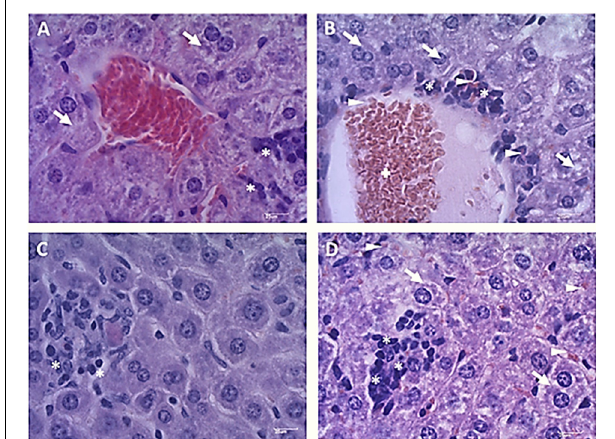
nuclei positioned at the cell center were observed. Differences in the number of glomerular corpuscles, changes in the Bowman’s space and tubule diameters were observed ( Supplementary Table S4 ). No significant differences were observed between the renal cortexes of mice treated with Fluopsin C and placebo ( Supplementary Figure S4 ).